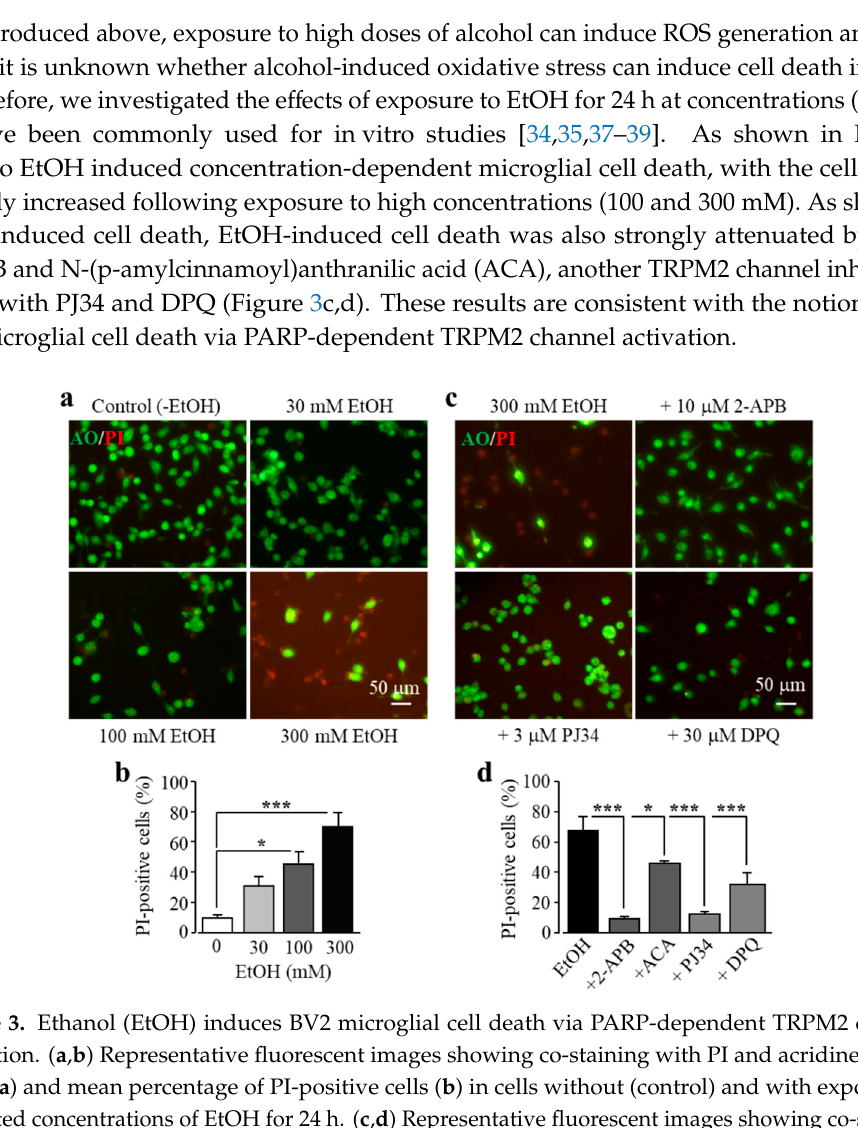
( c – h ) Representative fluorescent images showing co-staining with PI and Hoechst in cells exposed to 300 µ M H 2 O 2 for 24 h without and with treatment with indicated inhibitors ( c , e , g ) and mean percentage of PI-positive cells ( d , f , h ). Cells were pre-treated with inhibitors 30 min prior to and during exposure to H 2 O 2 . Mean data are from at least three independent experiments, using three wells of cells for each condition in each experiment. *** p < 0.005 compared to indicated group.